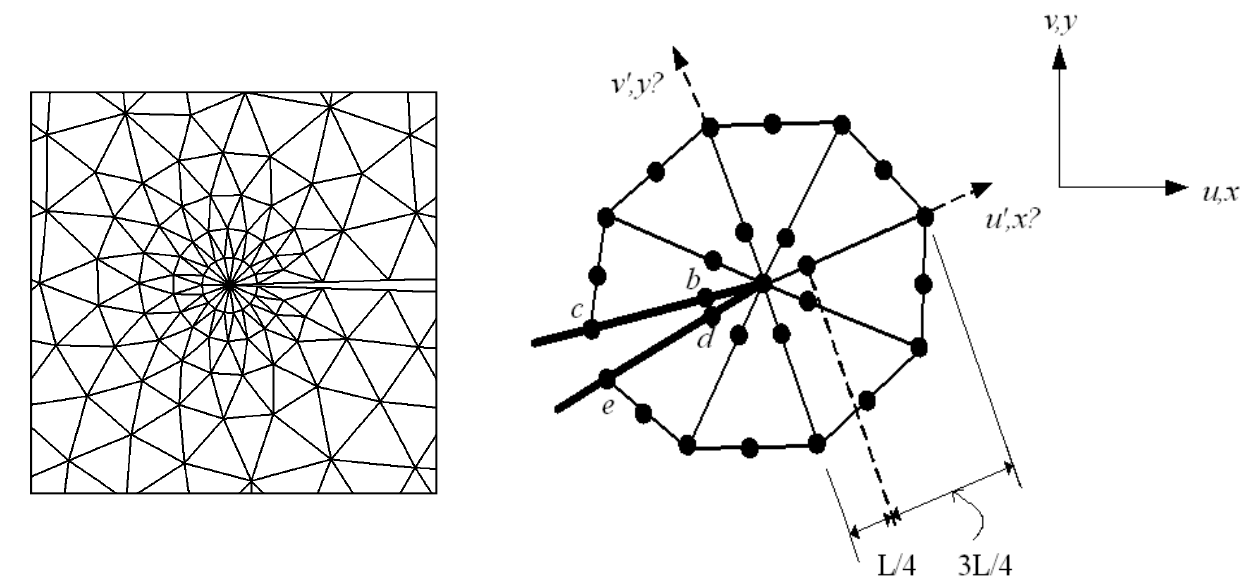
Figure 4. Elements and coordinates of a triangular rosette at the crack front.